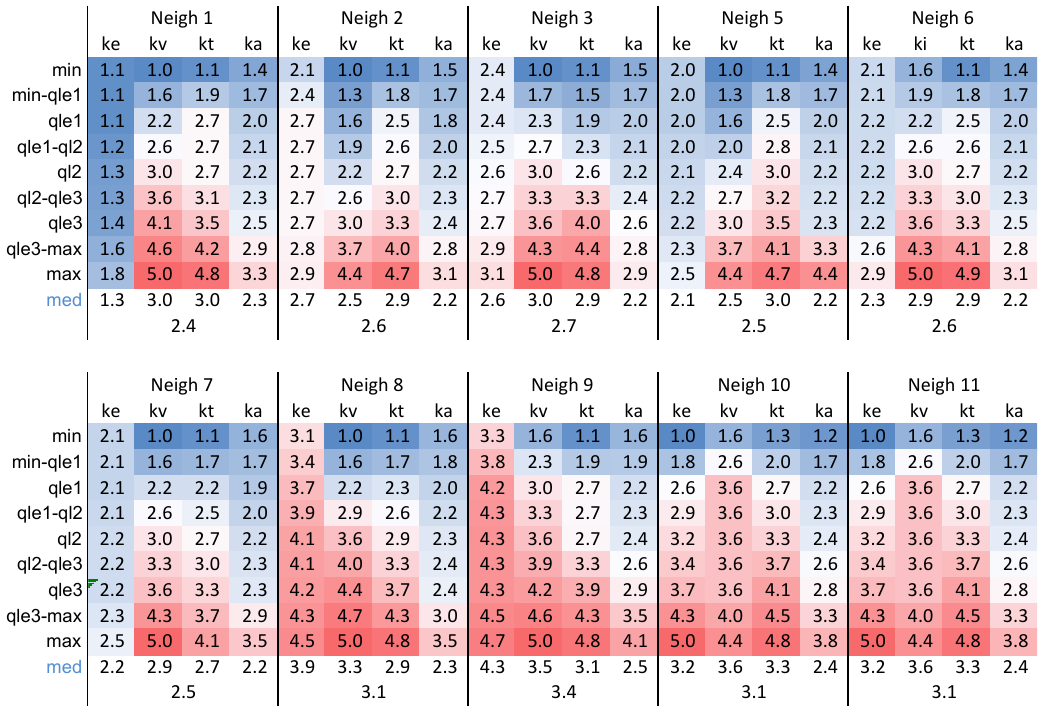
Figure 12. Comparison of the 10 neighbourhoods by minimum, average, maximum, and quartiles (normalised) scores of the main characteristics.